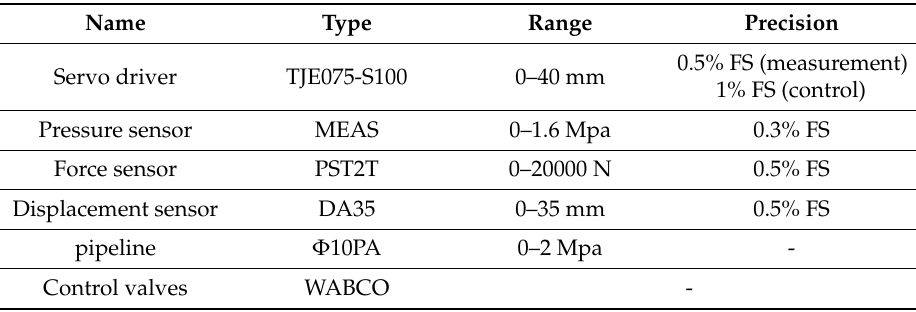
Table 1. Key parameters of test bench. (FS: full scale).